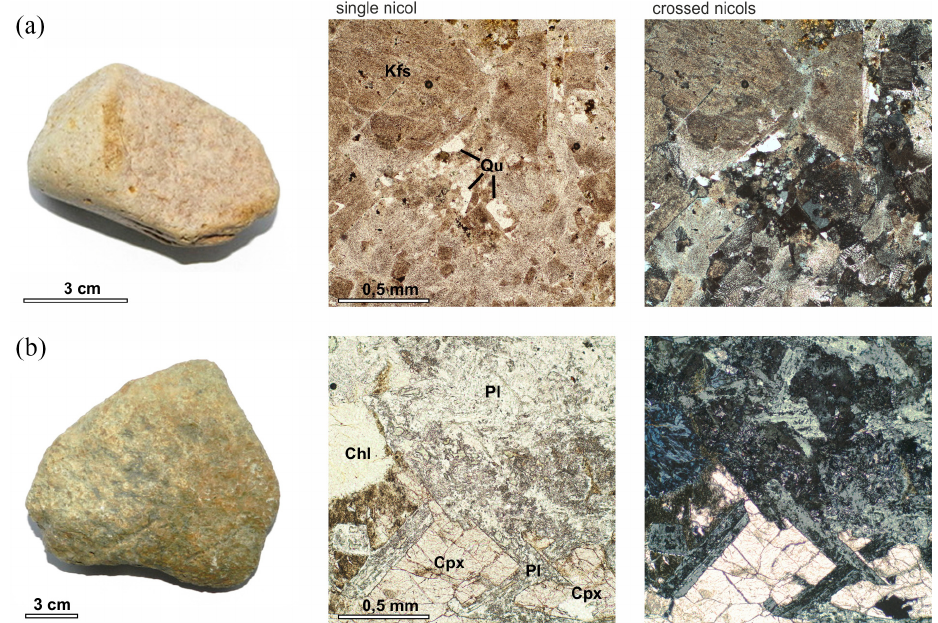
Figure 8. (a) Sample N-10 – pinkish quartz trachyte, with large inclusions of potassic feldspar (Kfs) with fine quartz grains (Qu) in the quartz-feldspathic matrix; (b) sample N-14: greenish-brown dolerite, with large poikilitic clinopyroxene crystals (Cpx) with thin plagioclase crystals (Pl); in the groundmass: plagioclase chlorite (Chl).